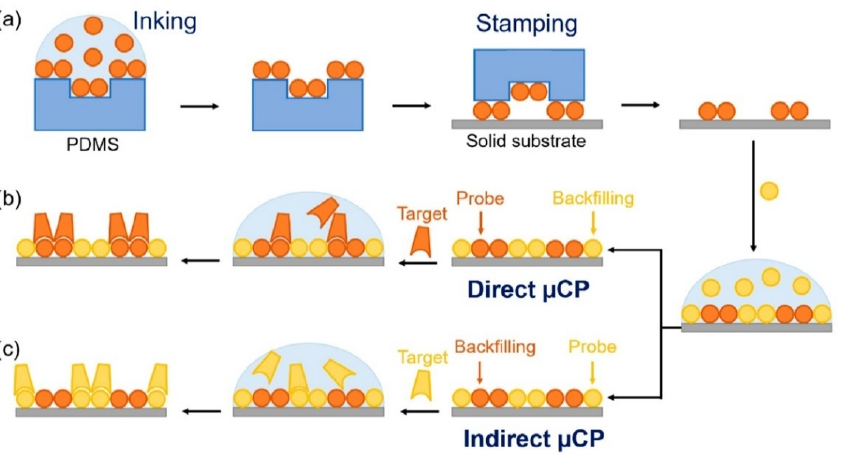
Figure 14. Schematic illustration of the fabrication and biorecognition processes, including ( a ) inking and stamping, ( b ) standard microcontact printing (µCP), and ( c ) indirect µCP. Note that in standard µCP, probes are patterned by stamping, whereas in indirect µCP, backfilling agents are stamped first and then the probes are physisorbed on the gaps just by incubation. Reproduced from ref. [200]. Copyright 2018, MDPI.